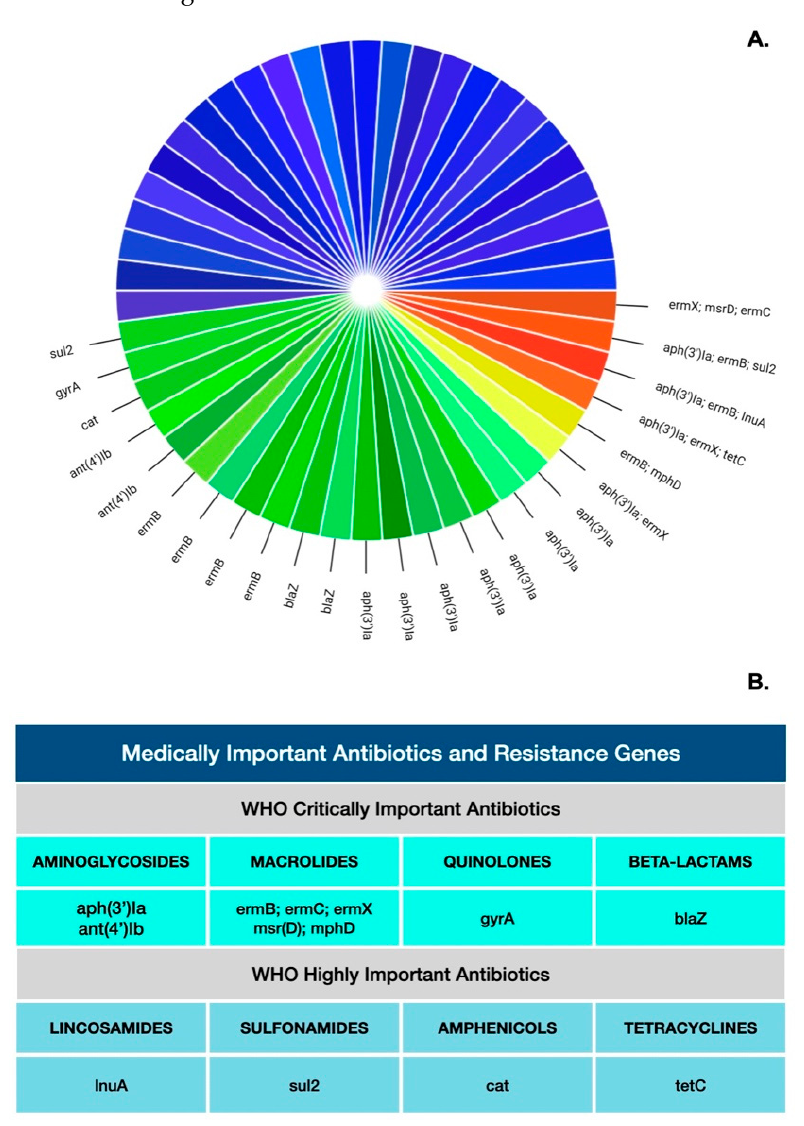
Figure 1. AMR gene presence in urine microbiome samples from clinically healthy dogs. The pie- chart slices represent individual dogs ( n = 50) included in the study ( A ). Slices in gradients of red, yellow, and green represent samples containing 3, 2, and 1 AMR genes, respectively. Samples shown in gradients of blue were negative for all tested AMR genes. All 13 AMR genes detected in samples from 24 dogs confer resistance against antibiotics defined by the WHO as medically important ( B ).